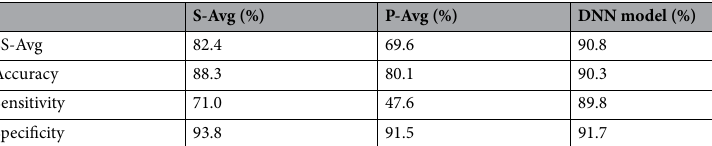
Table 2. Comparison between radiologists and DNN models in the first diagnostic examination (no AI support). S-Avg: Average results for radiological specialists (board-certified radiologists). P-Avg: Average results for radiological practitioners (no board-certified radiologists). The results of DNN model were calculated using the average for the top 10 combinations of MRI sequences (Table 1). The DNN results were equivalent to those of a radiological specialist, and the SS-Avg and sensitivity were significantly higher for the DNN models ( p < 0.05 for both parameters).